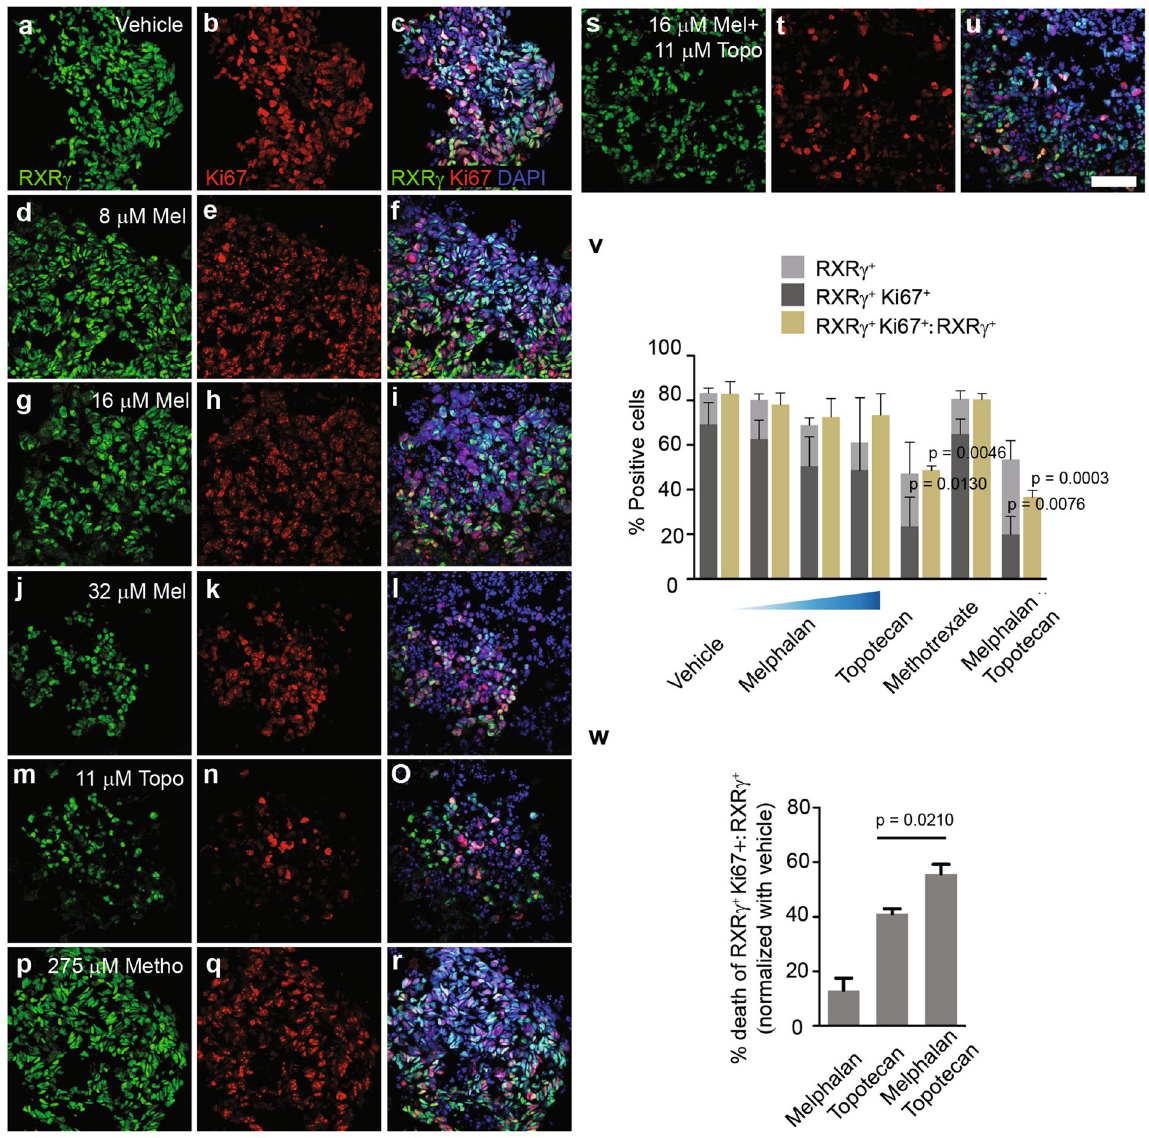
Figure 6. Cone cell features in organoids in response to anticancer drugs at 24 h. ( a–u ) Representative micrographs of co-immunostaining for cone marker RXR γ ( a , d , g , j , m , p , s ) and proliferative marker Ki67 ( b , e , h , k , n , q , t ) in organoids treated with vehicle ( a–c ), 8 ( d–f ), 16 ( g–i ), or 32 ( j–l ) µ M melphalan (Mel), 11 µ M topotecan (Topo) ( m – o ), 275 µ M methotrexate (Metho) ( p – r ), or the combined regimen of 16 µ M melphalan with 11 µ M topotecan ( s – u ). Merged images ( c , f , i , l , o , r , u ). Nuclei stained by 4 ′ ,6-diamidino-2-phenylindole (DAPI). Scale bar, 50 µ m. ( v ) Bar graph shows % RXR γ + cells (non-proliferative cones), RXR γ + cells co-stained with Ki67 (proliferative cones), and ratio of proliferative to non-proliferative cones (mean percentages ± SEM, n = 3). Mean percentages (proportions) were determined in nine micrographs for each condition. Statistical analysis of % positive cells was conducted by one-way ANOVA followed by Dunnett’s test. ( w ) Bar graph shows death of cell ratio of RXR γ + Ki67 + to RXR γ + (mean percentages ± SEM, n = 3, unpaired